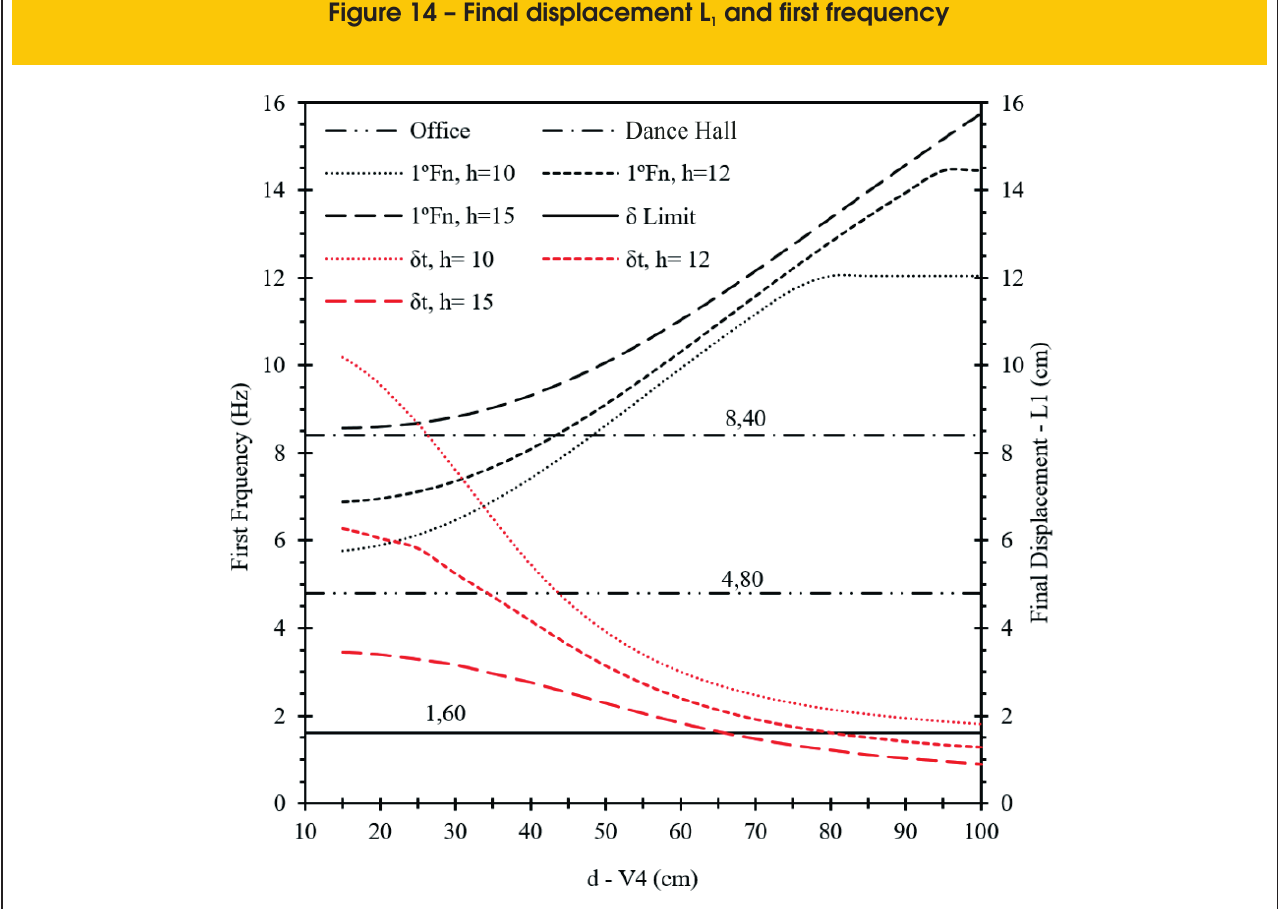
Figure 14 – Final displacement L and first frequency